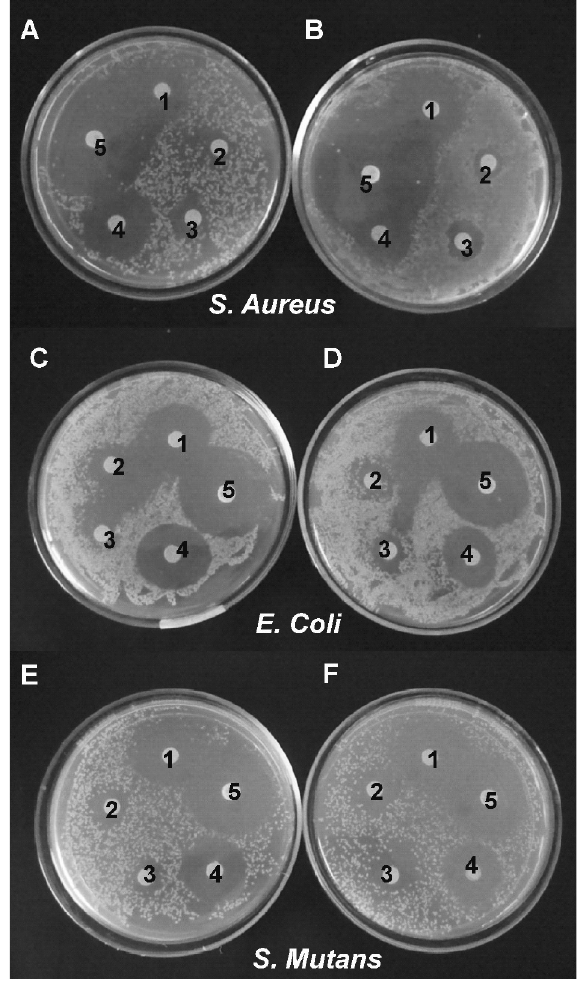
Figure 1. Antibacterial test with disk diffusion method. (A), (C) and (E) agar plates show disks with unpolymerised adhesive. (B), (D) and (F) agar plates show disks with polymerised adhesive. (1) Chlorhexidine 0.2%. (2) Adhesive +0.0050 wt% copper NPs. (3) Adhesive +0.0075 wt% copper NPs. (4) Adhesive +0.0100 wt% copper NPs. (5) Specific drug for each